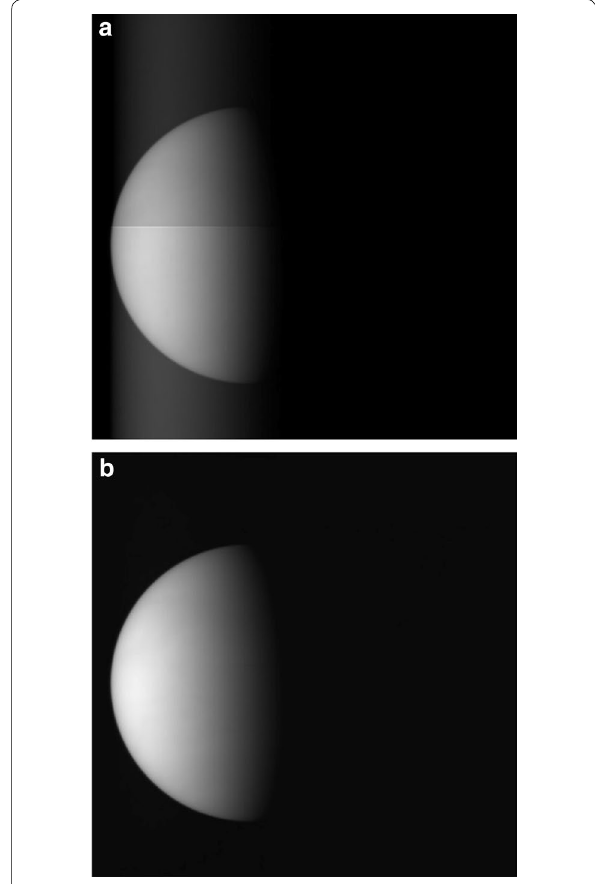
Fig. 4 a An example of a Level 1 image: a raw image before cor‑ rection, taken at 08:01 on May 07, 2016, at a distance of 91,000 km with a sub‑spacecraft latitude of 10° and a longitude of 325°. b An − example of a Level 2 image: a cleaned image of Fig. 4a after smear‑ like noise correction and flattening procedure. These corrections and procedures are described in the